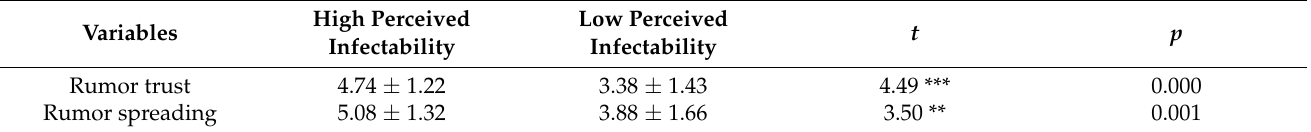
Table 3. Independent samples t test in Study